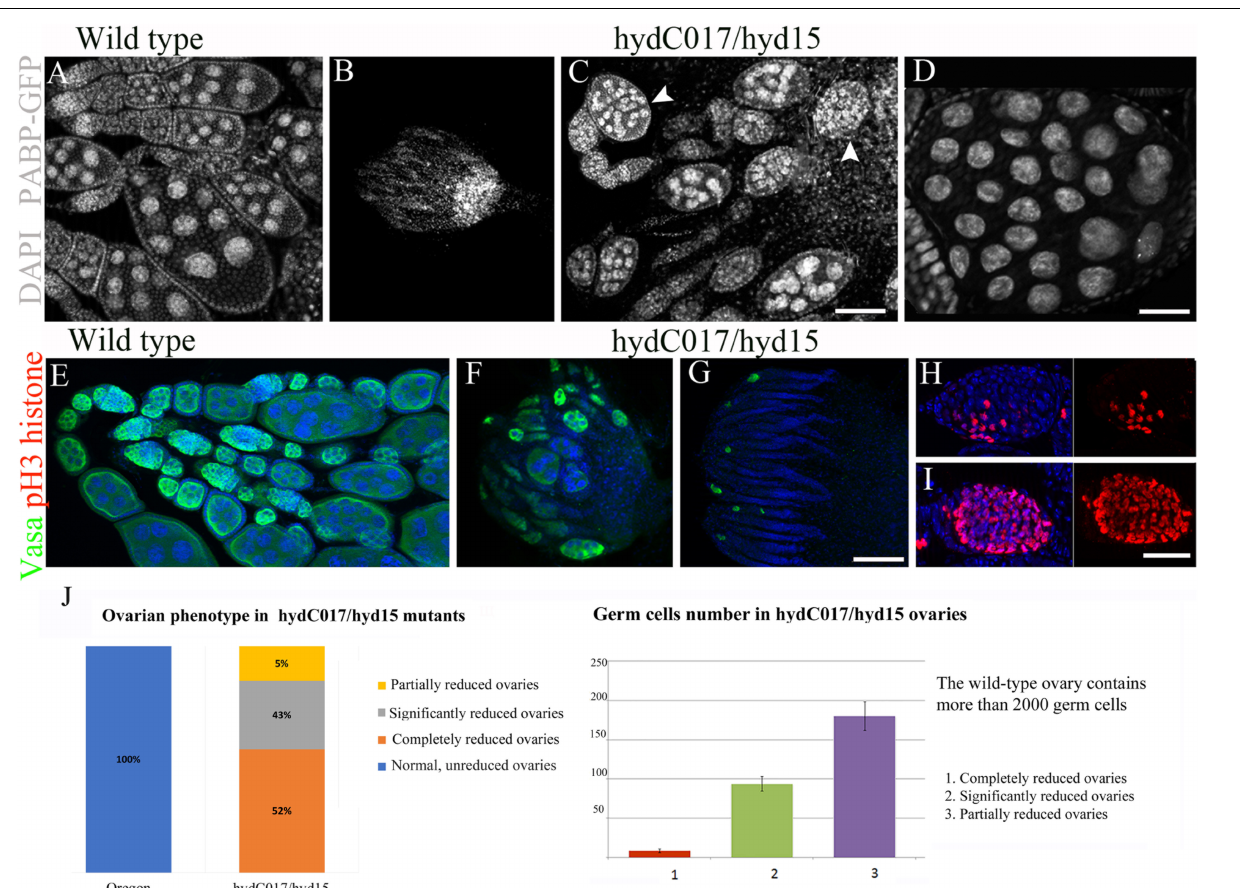
FIGURE 2 | Abnormalities of oogenesis and ovary formation in hydC017/hyd15 females. (A) Normal ovarian morphology in wild-type females. (B) A reduced ovary of a hydC017/hyd15 female without ovarioles and EChs. (C) A hydC017/hyd15 female ovary with few ovarioles containing multi-nuclear EChs (arrowheads). (D) A multi-nuclear ECh in a hydC017/hyd15 ovary. (E–G) Germ cell visualization by anti-Vasa staining in germaria and EChs. (E) Wild-type ovary. (F,G) Germline loss in a hydC017/hyd15 female ovary. (H,I) Visualization of mitotic chromosomes in germline cysts using an anti-p-H3 histone antibody. Anaphase chromosomes in the wild type (H) and an excessive number of anaphase chromosomes in a hydC017/hyd15 germline cyst (I) . ( J ) Phenotypic variability of reduced ovaries in hydC017/hyd15 mutants and quantification of the germ cell numbers in the hydC017/hyd15 ovaries. The number of germ cells per ovary was determined by counting VASA-positive cells from optical serial sections, 30 ovaries for each phenotype were examined. Data represent mean ± s.d., Student’s t -test. For phenotypic analysis, the number of ovaries viewed—100. DNA: DAPI (blue), anti-Vasa staining: red, p-H3 histone staining: green. Scale bars: 10 µ m (A–C) , 3 µ m (D) , 10 µ m (E–G) , 2 µ m